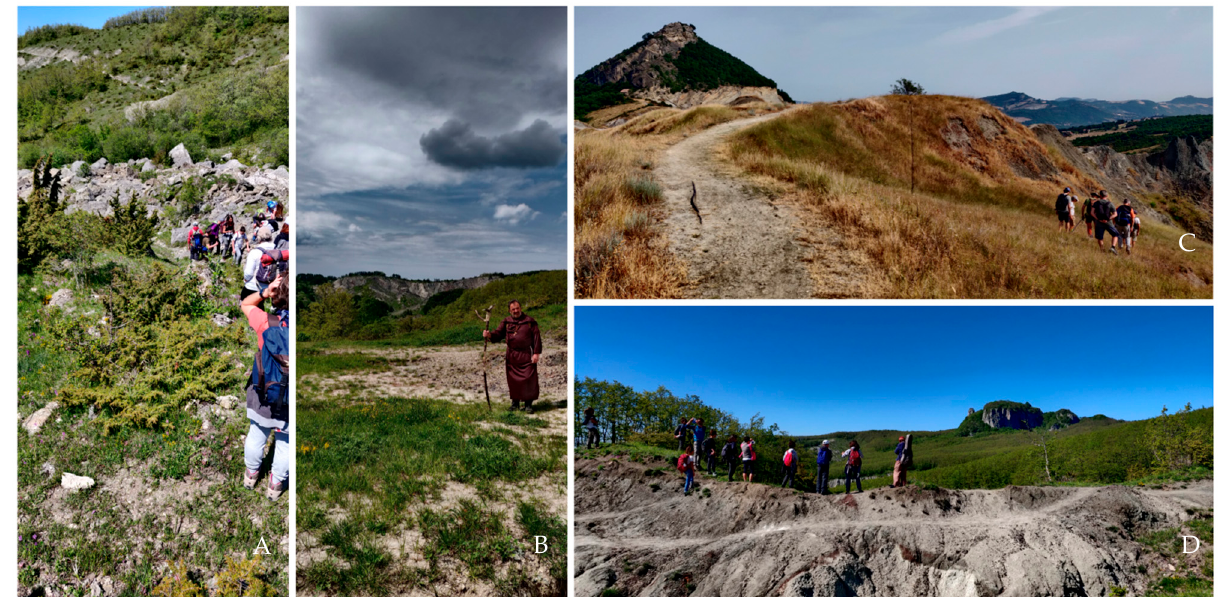
Figure 9. Pictures from Paesaggeo ’s excursions: ( A ) Trekking in a Geolandscape; ( B ) A story in the Geolandscape; ( C ) Let’s explore a Geolandscape; ( D ) Let’s listen to the Geolandscape.